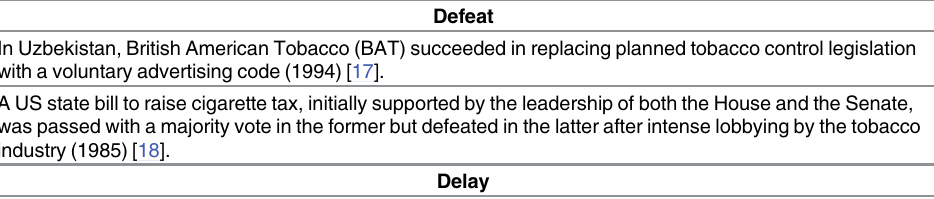
Table 2. Tobacco industry preferred outcomes for tobacco control policies with